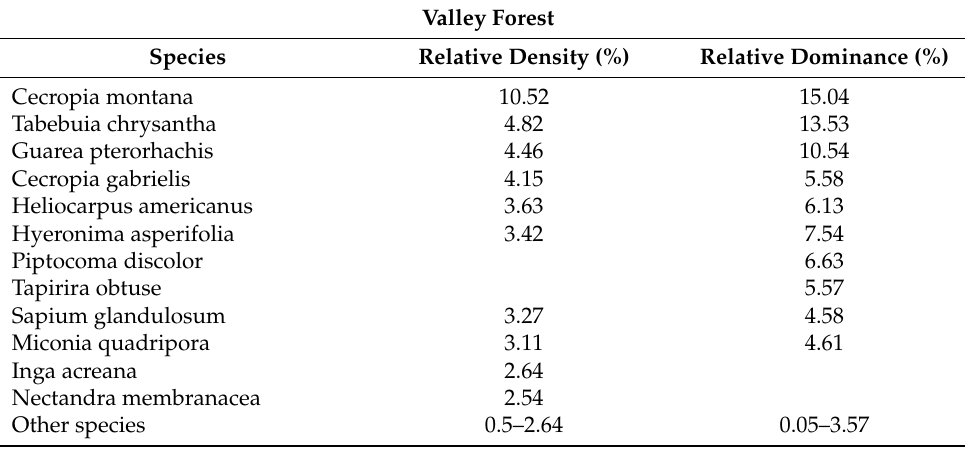
Table 4. Values of relative density and relative dominance in the VF.